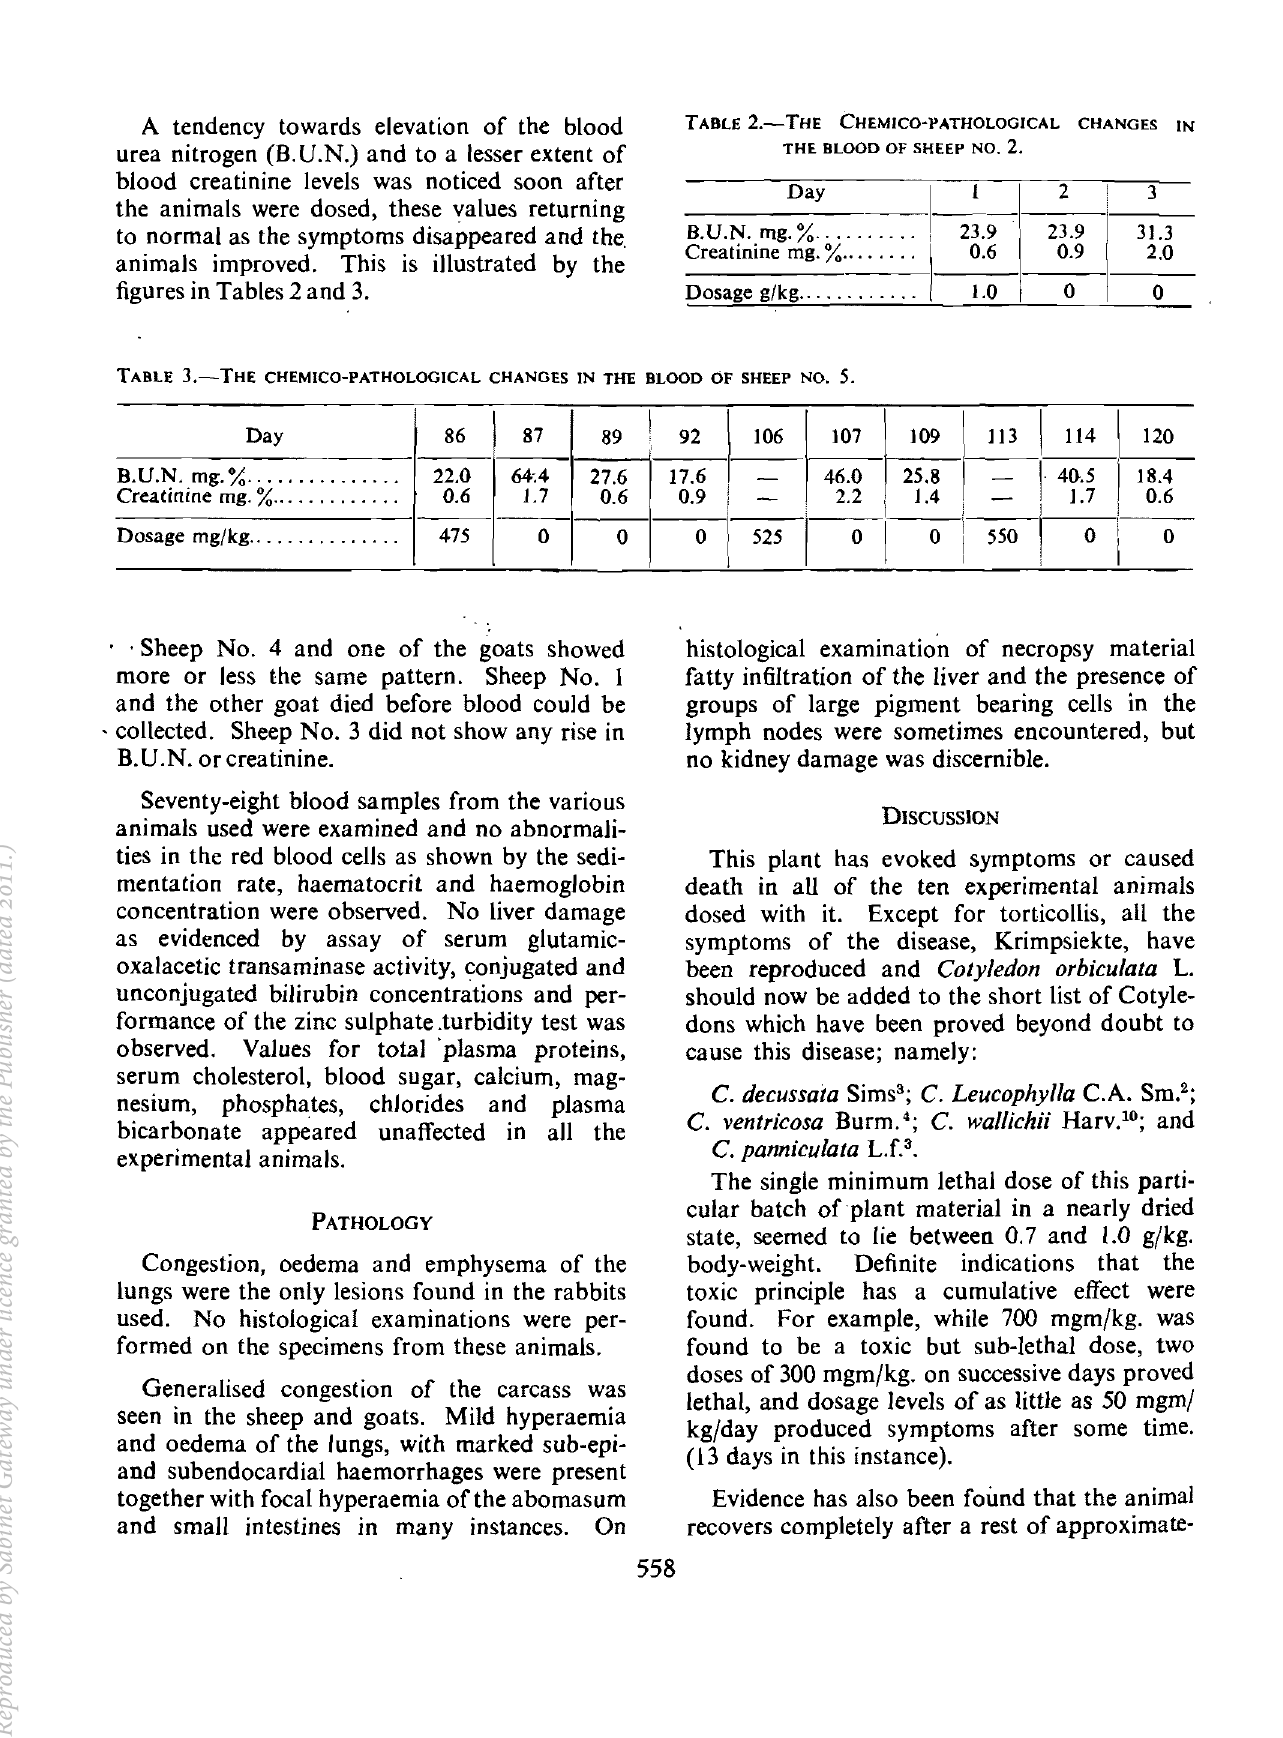
TABLE 3.-THE CHEMICO-PATHOLOGICAL CHANGES IN THE BLOOD OF SHEEP